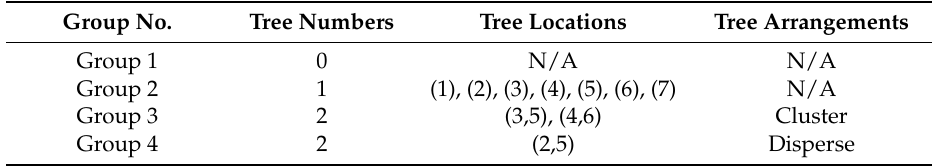
Table 3. Key factors in different experimental groups.